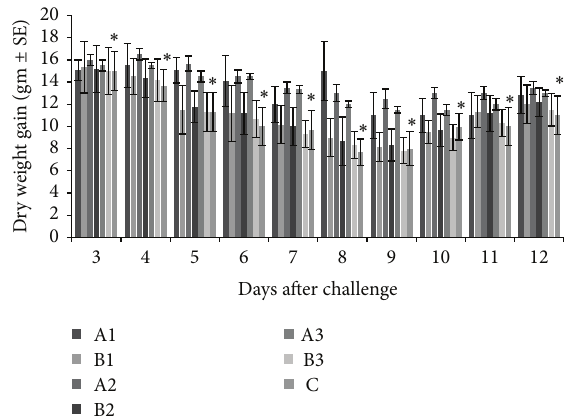
Figure 3: Daily weight gains from day 3 to 12 after challenge in experimental and control chickens. A1 = Emblica officinalis derived tannins at 0.50 gm/Kg b. wt; B1 = commercial tannins at 0.50 gm/Kg b. wt; A2 = Emblica officinalis derived tannins at 0.75 gm/Kg b. wt; B2 = commercial tannins at 0.75 gm/Kg b. wt; A3 = Emblica officinalis derived tannins at 1.00 gm/Kg b. wt; B3 = commercial tannins at 1.00 gm/Kg b. wt; C = PBS-administered negative control ( ∗ significantly lower